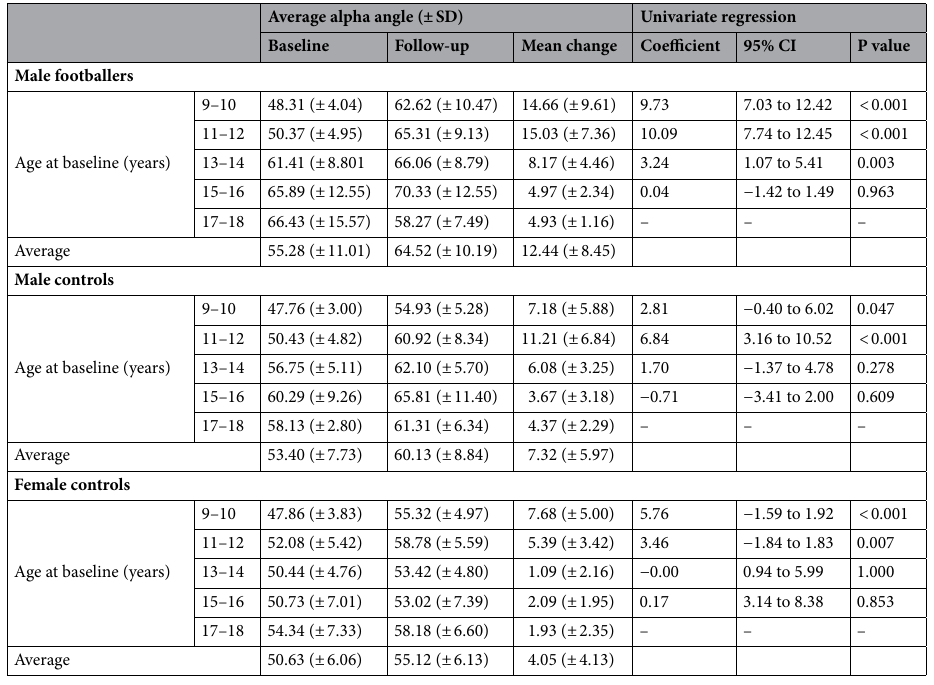
Table 3. Change in average alpha angle with age by